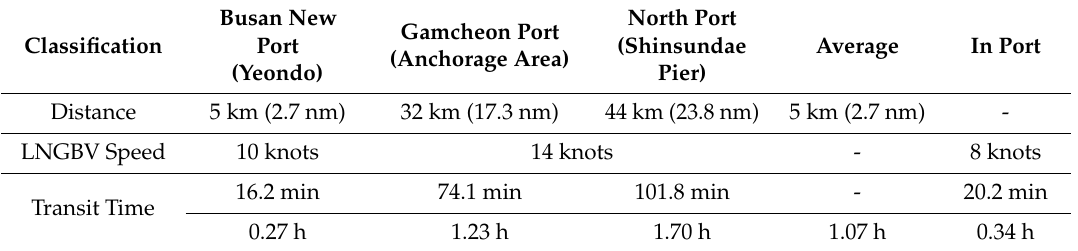
Table 10. Transit Time by STS in Busan Port.